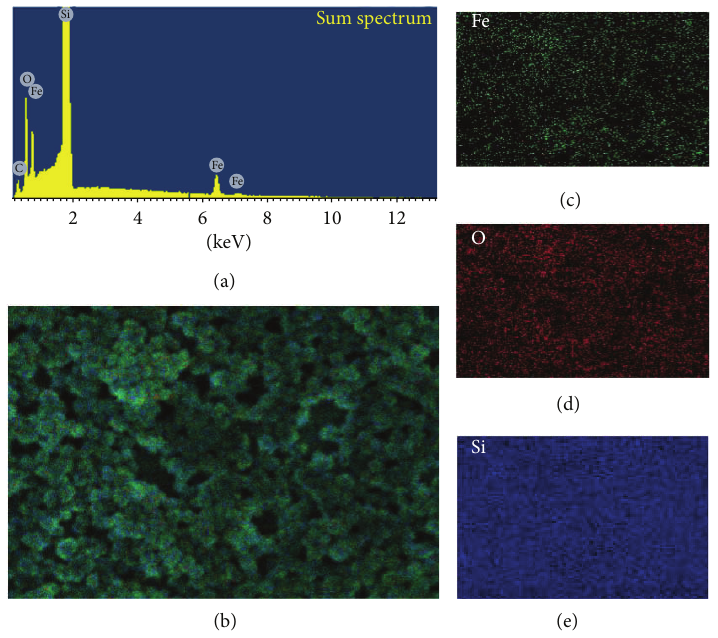
Figure 5: (a) EDX analysis and (b) FESEM-EDX elemental mapping of 𝛼 -Fe 2 O 3 nanoparticles on Si wafer for different elements: (c) Fe, (d) O, and (e) Si.